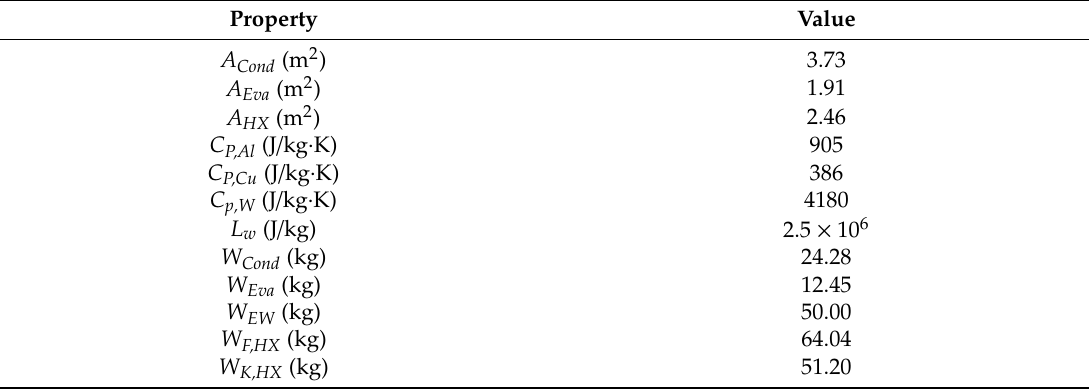
Table 5. Physical properties of two-bed type AD system